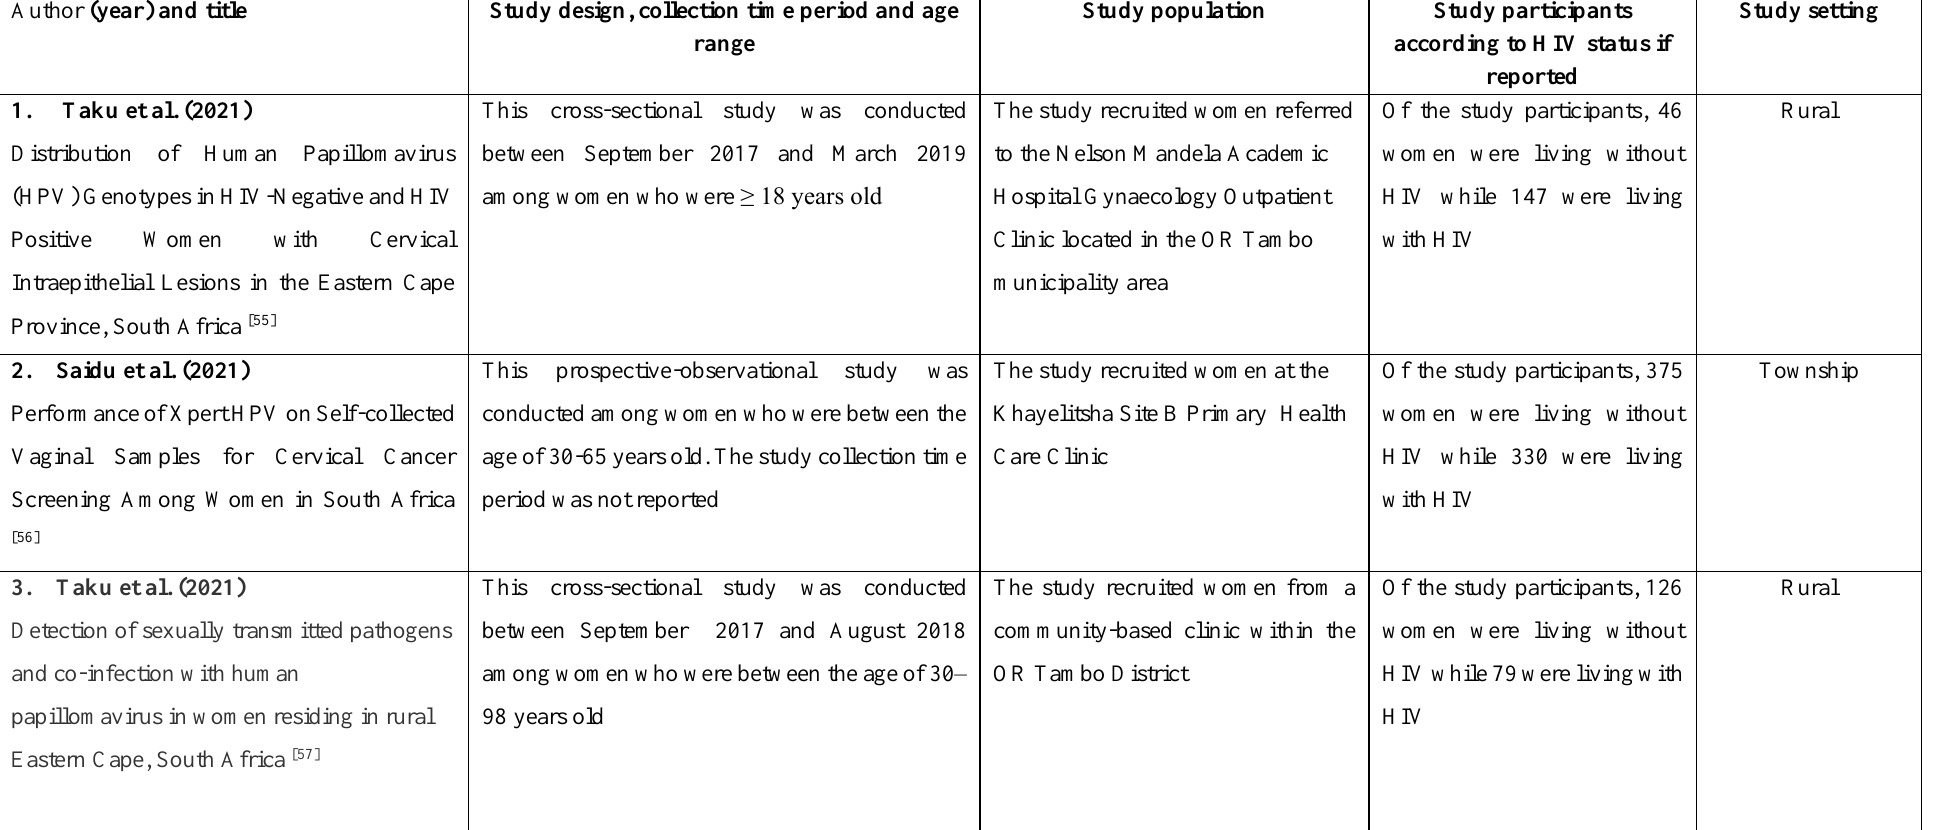
Table 1: Characteristics of the 68 articles analysed for HPV among South African women living with and without HIV Author (year) and